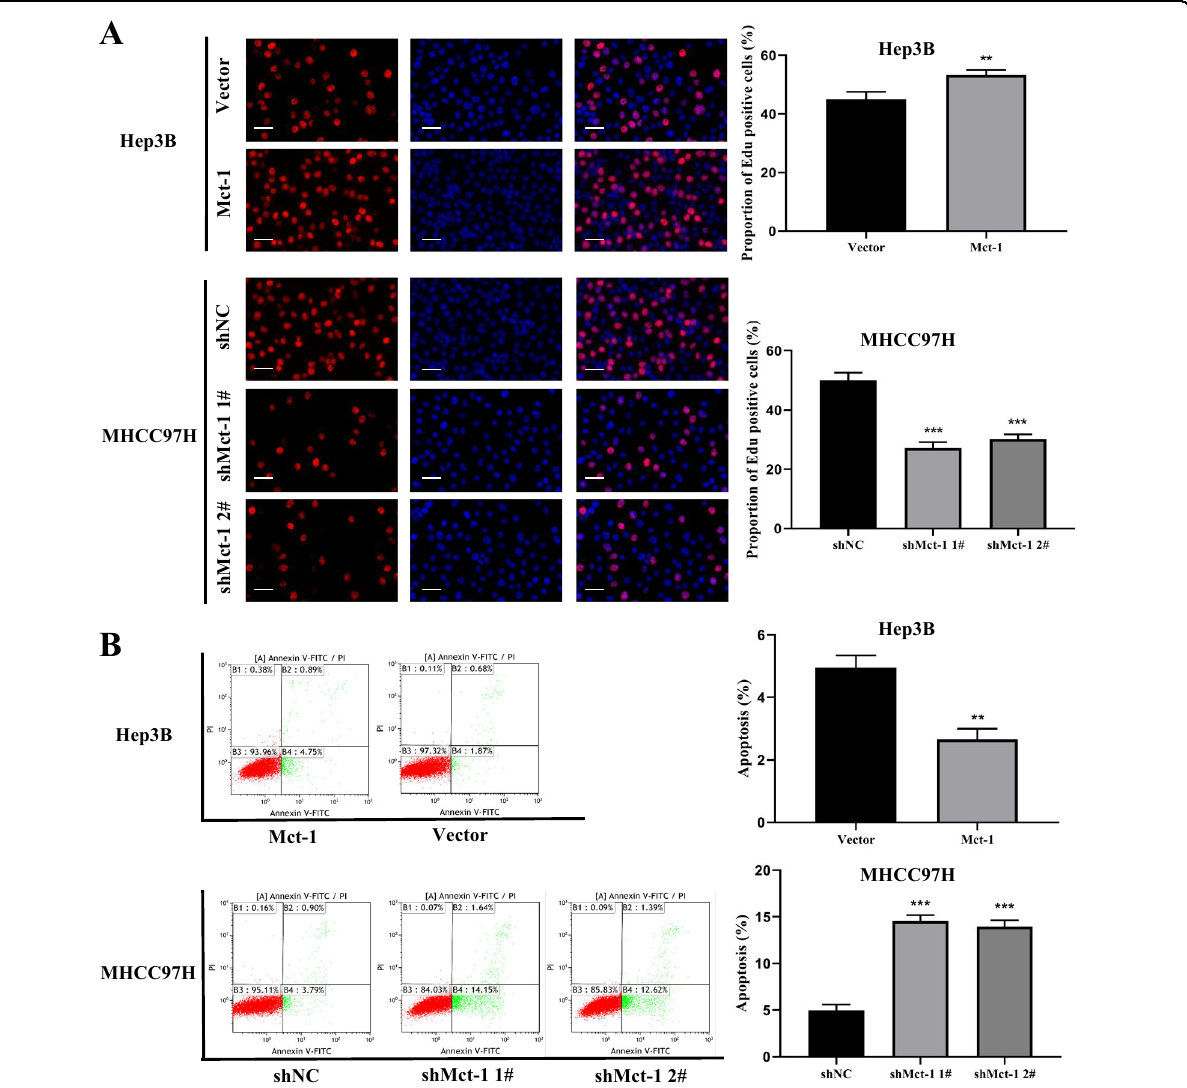
Fig. 4 Mct-1 has potent oncogenic functions in HCC. A The Edu assay was used to assess the proliferation of MHCC-97H and Hep3B cells following Mct-1 knockdown or overexpression. Scale bar = 50 µm. B Flow cytometry was performed to assess the apoptosis rate of MHCC-97H and Hep3B cells following Mct-1 knockdown or overexpression. The data are presented as the mean ± SD of experiments performed in triplicate. * p < 0.05, ** p < 0.01, *** p <